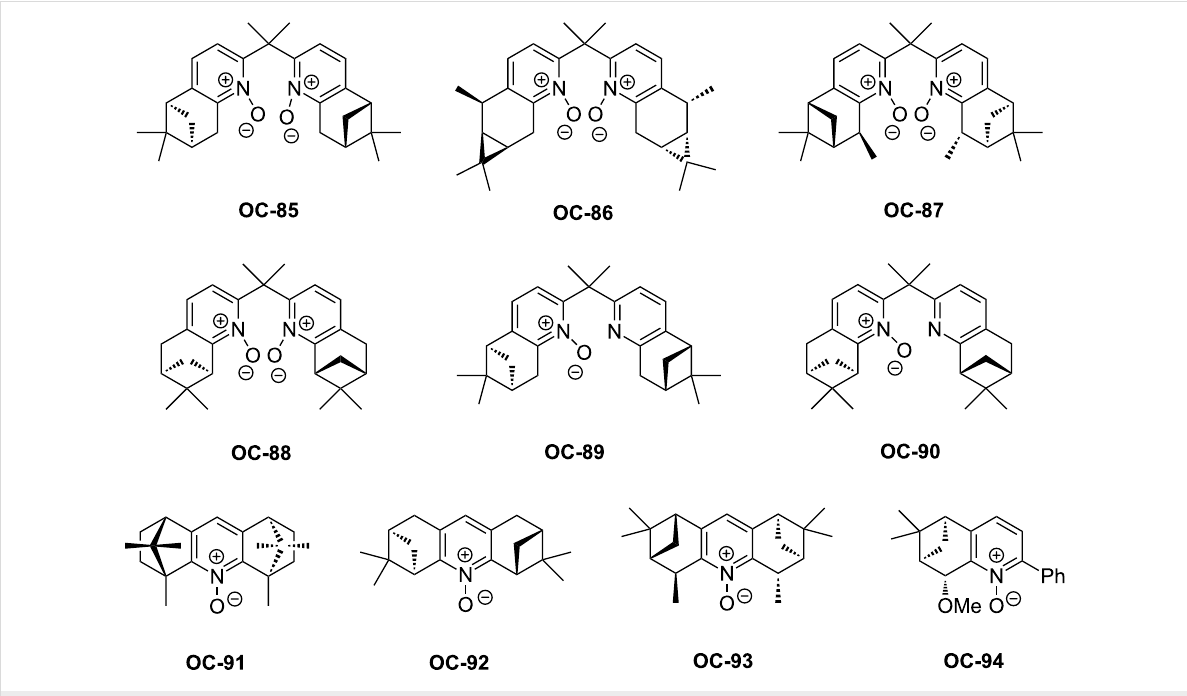
Figure 17: Chiral pyridine N -oxides OC-85 to OC-94 .